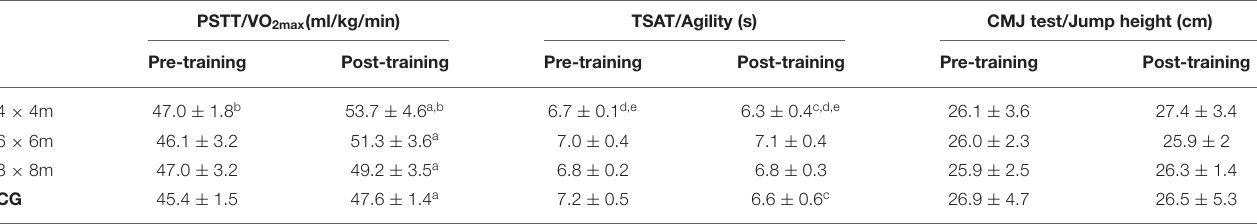
TABLE 2 | Performance variables before and after the training period (values are mean ± SD) for the 4 × 4m group (4 × 4m and n = 8), the 6 × 6m group (6 × 6m and n = 8), the 8 × 8m group (8 × 8m and n = 8) and the control group (CG and n = 8). PSTT/VO 2max (ml/kg/min) TSAT/Agility (s) CMJ test/Jump height